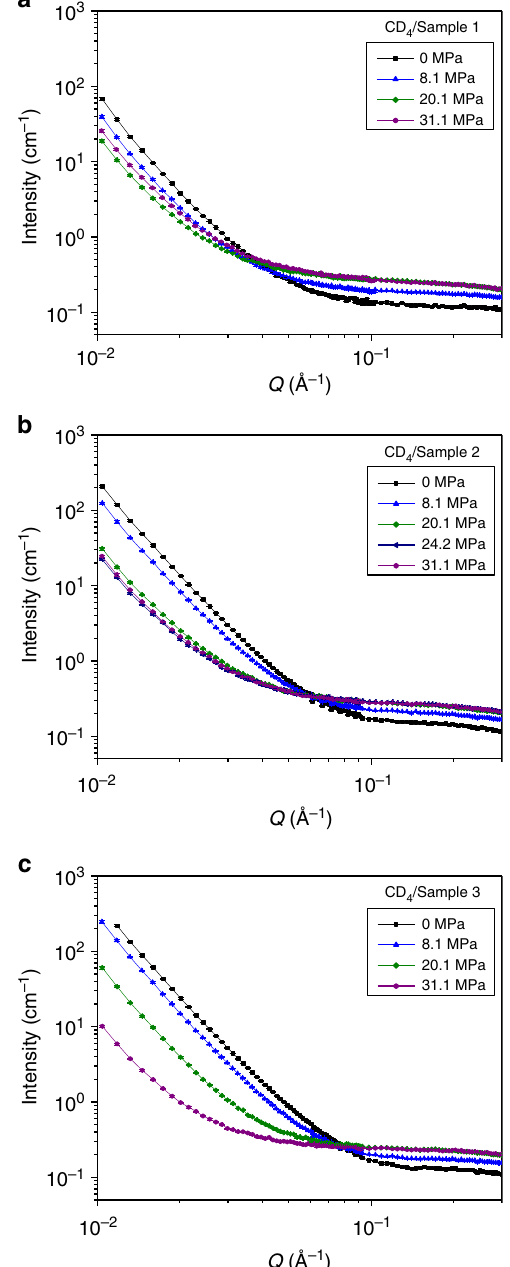
Fig. 3 Small-angle neutron scattering experimental data for isolated shale kerogens loaded with probing fl uid CD 4 . a Sample 1 (least mature kerogen)/CD 4 . b Sample 2/CD 4 . c Sample 3 (most mature kerogen)/CD 4 . CD 4 pressure ranges from 0 to 31.1 MPa. At high Q , the intensity fl attens